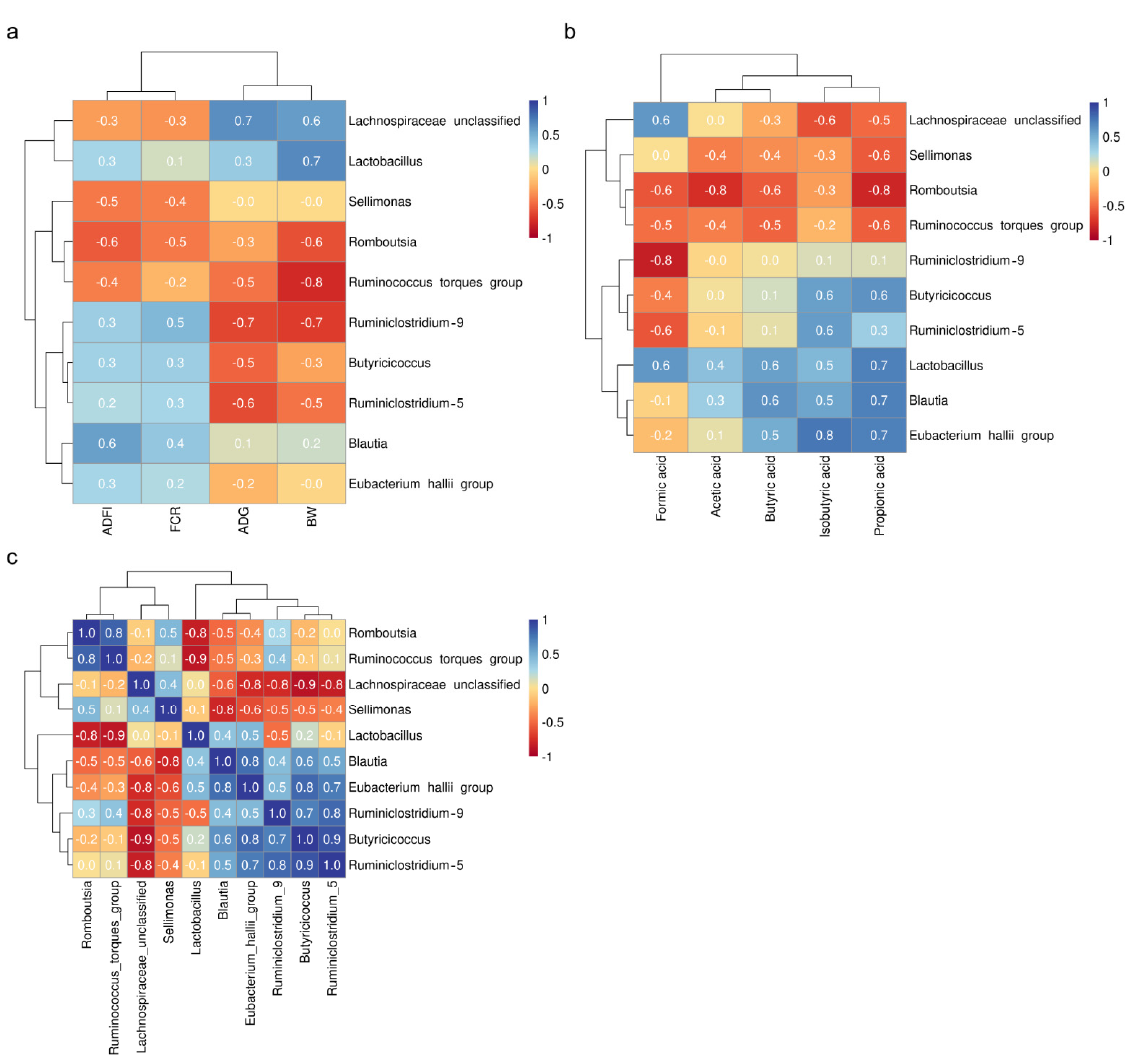
Figure 3. Pearson’s correlation analysis. ( a ) The correlation coefficient between the dominant 10 genera and cecal short-chain fatty acid. ( b ) The correlation coefficient between the dominant 10 genera and growth performance of broilers. ADFI: average daily feed intake, FCR: feed conversion ratio, ADG: average daily gain, BW: body weight. ( c ) The correlation coefficient among the dominant 10 genera. The positive correlations are shown in blue, while the negative correlations are shown in red. The color intensity and the size of the circle are proportional to the correlation coefficients. The values from +1 to − 1 indicate the strength of the